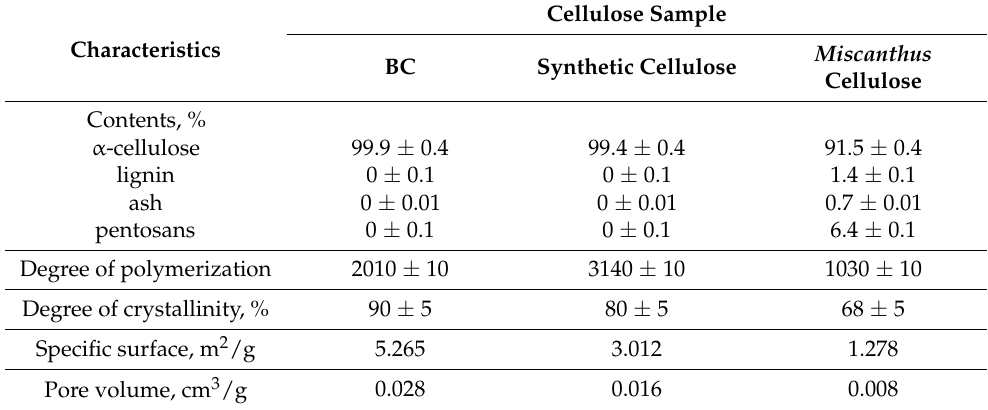
Table 1. Properties of cellulose samples.